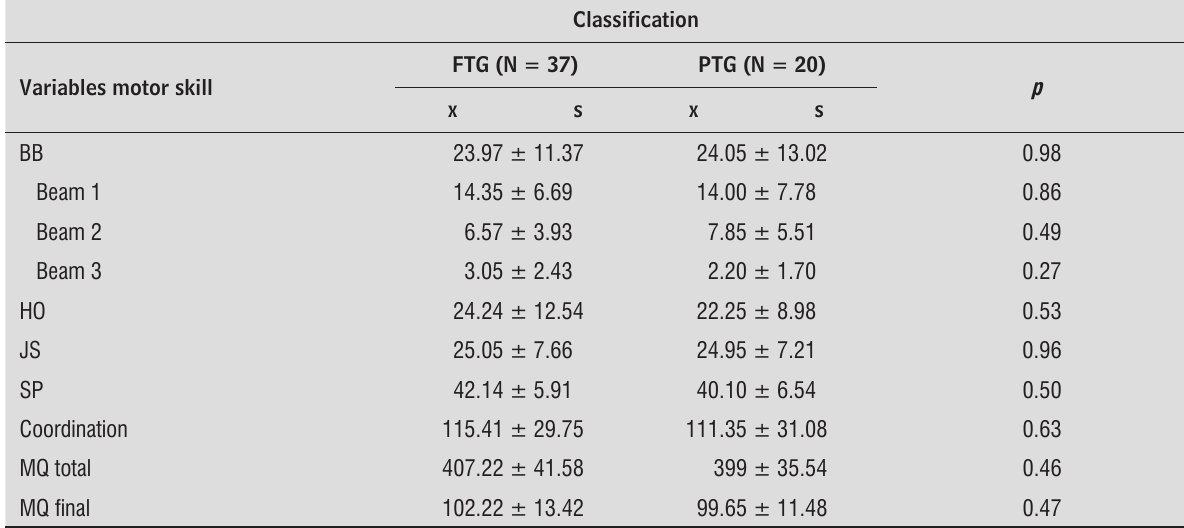
Table 3 - Scores in the battery of KTK tests of the groups of children preterm (PTG) and full-term (FTG)